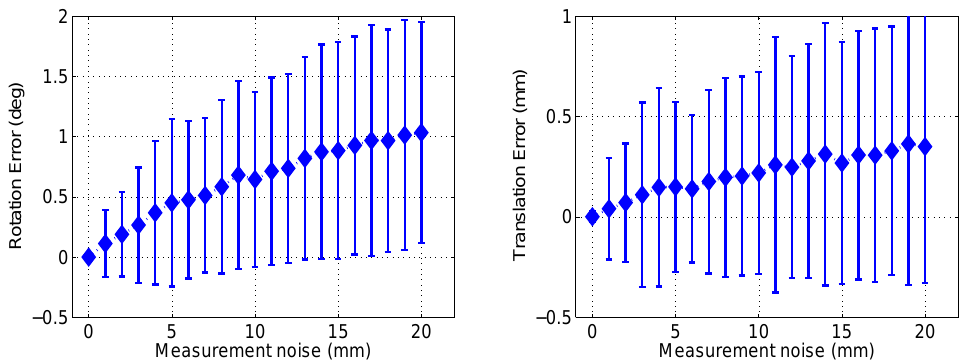
Figure 4. Experimental results using synthetic data. The value x of ‘Measurement noise’ (horizontal axis) means that the noise added to the points are generated in the interval of [ − x , x ]